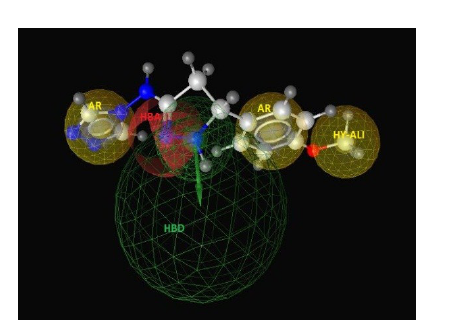
Figure 2 Pharmacophore mapping of Pyrazoline